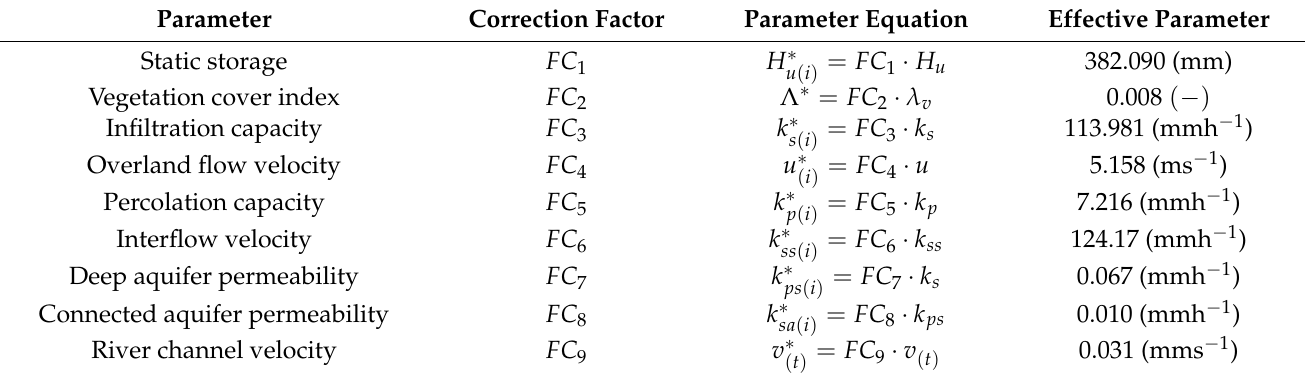
Table 2. Hydrological model’s effective mean parameters obtained by